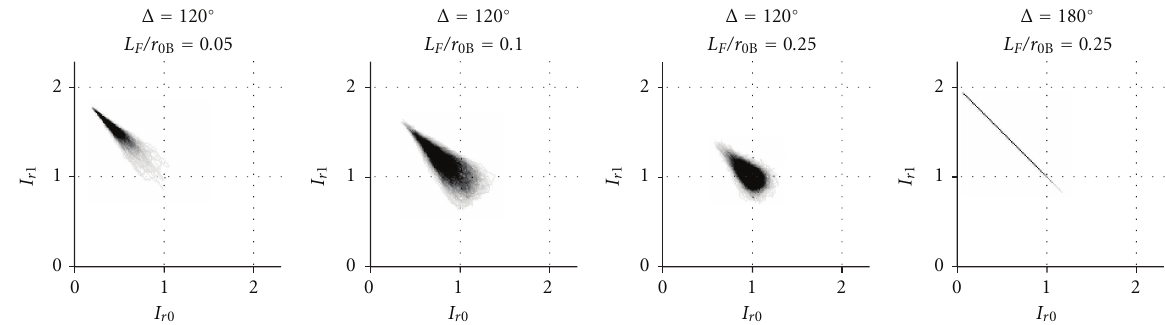
Figure 9: Two-dimensional probability density ρ ( I r 0 , I r 1 ) obtained with ( V d 0 , V d 1 ) = ( − 1, − 2), S hx = 0, M outer = 5 r 0 B , and di ff erent values of L F and Δ .